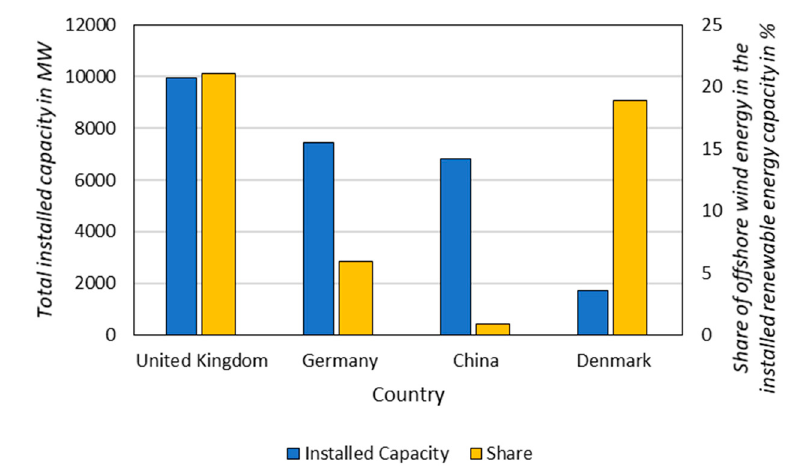
Figure 1. Comparison of offshore wind deployment and share of the offshore wind capacity in renewable generation in major markets (2019) [4,10].